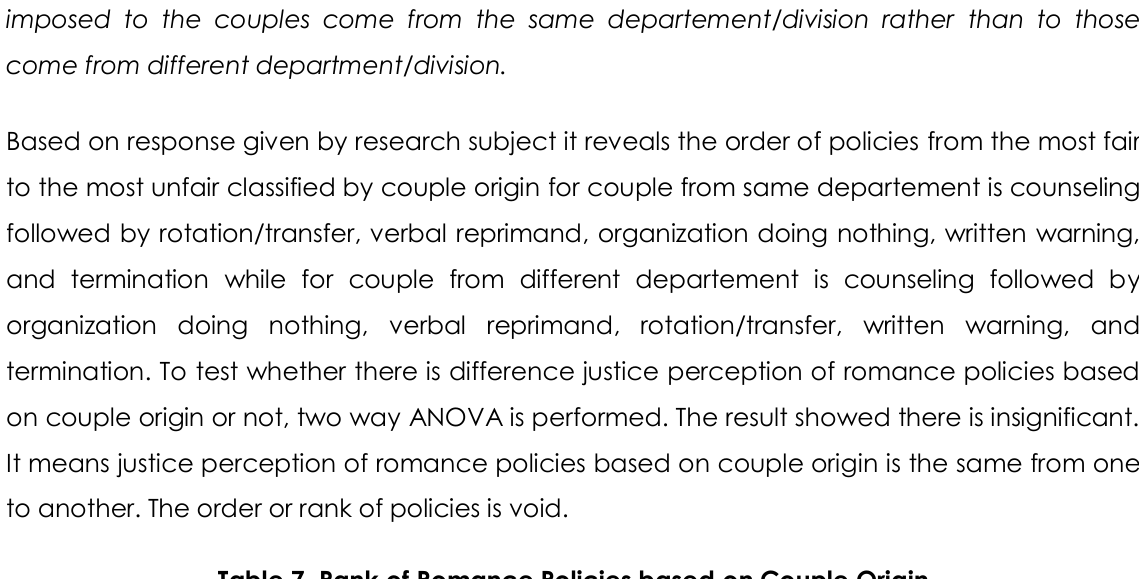
Table 7. Rank of Romance Policies based on Couple